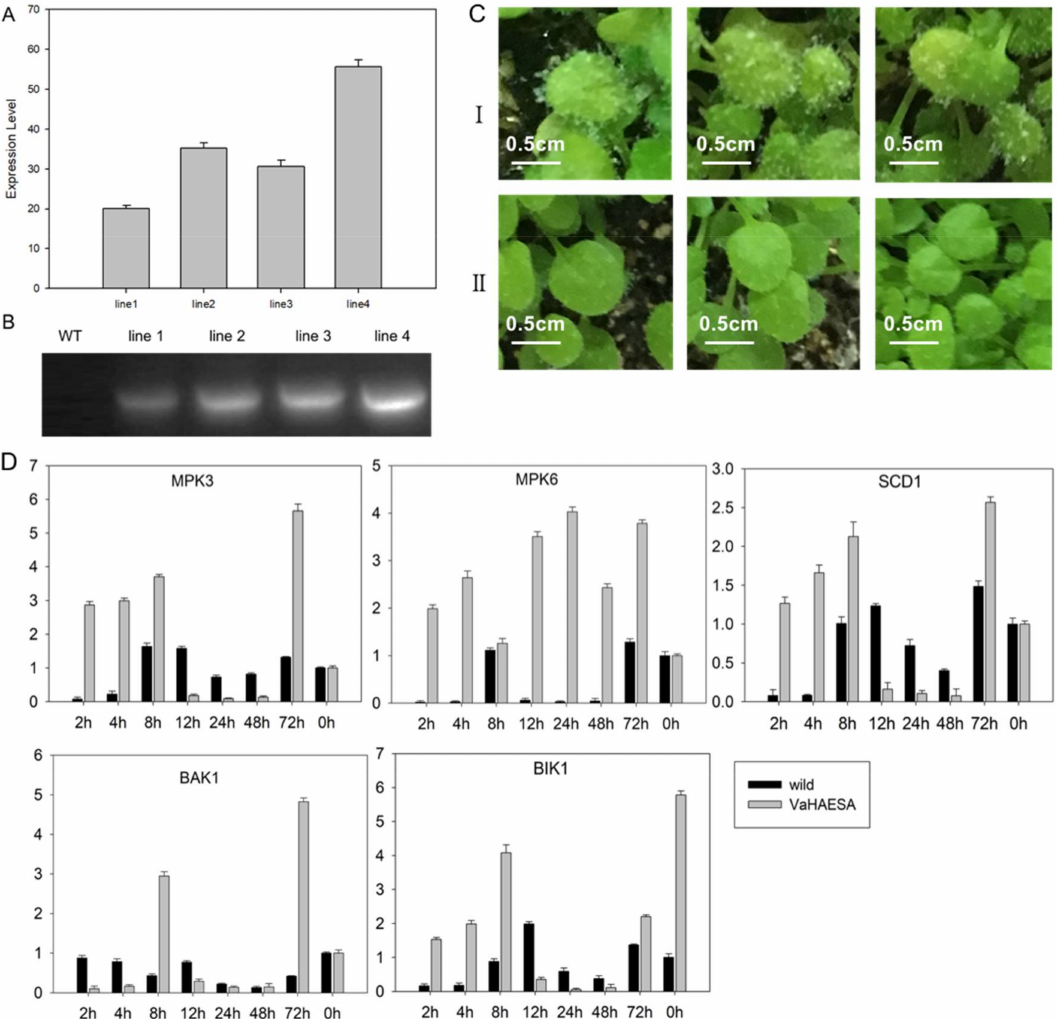
Figure 11. Identification of disease resistance in transgenic Arabidopsis thaliana and the expression patterns of related genes. ( A ) qRT-PCR analysis of VaHAESA expression levels in transgenic Arabidopsis thaliana ; ( B ) PCR detection of positive transgenic Arabidopsis thaliana ; ( C ) phenotypic identification of Arabidopsis thaliana after inoculation with H. arabidopsidis : I. wild type; II, transgenic Arabidopsis thaliana ; ( D ) the expression patterns of related genes in the pathogen-associated molecular patterns (PAMP)-triggered immunity (PTI) pathway. Values on vertical axes indicate the fold-change in gene expression, normalized to the expression levels of AtACTIN , AtSAND , and AtUBQ . The x -axes represent the time since inoculation. Error bars represent the standard deviation calculated from three